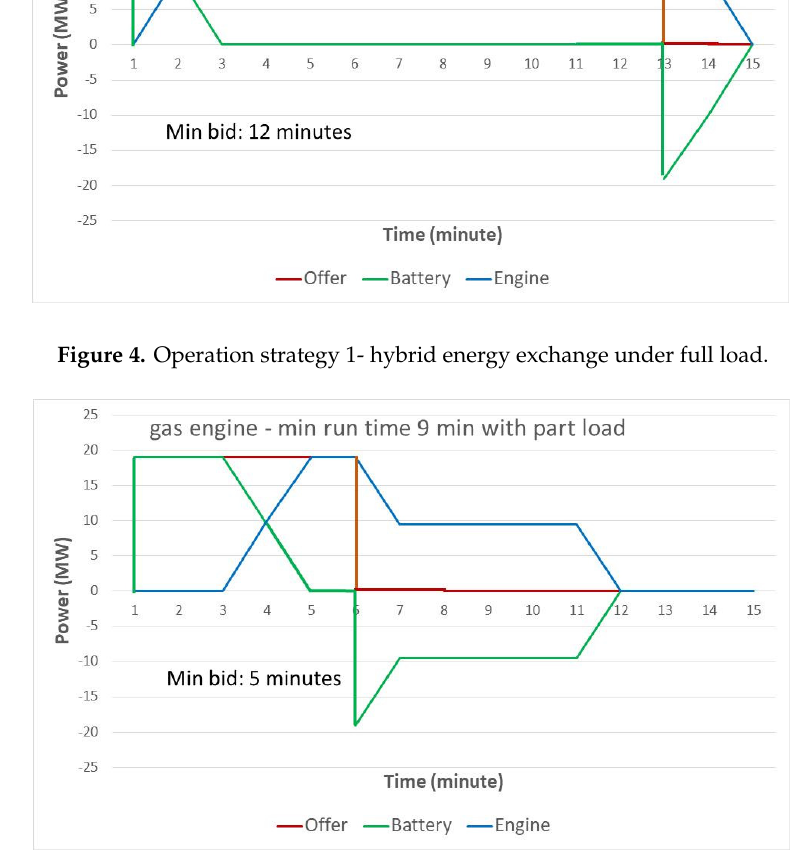
Figure 5. Operation strategy 1- hybrid energy exchange under part load.